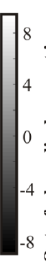
Figure 6. Out ‐ of ‐ plane displacements of the plate wave generated by a transducer array at t = 20 µs. For the animation of the wave field please refer to supplementary